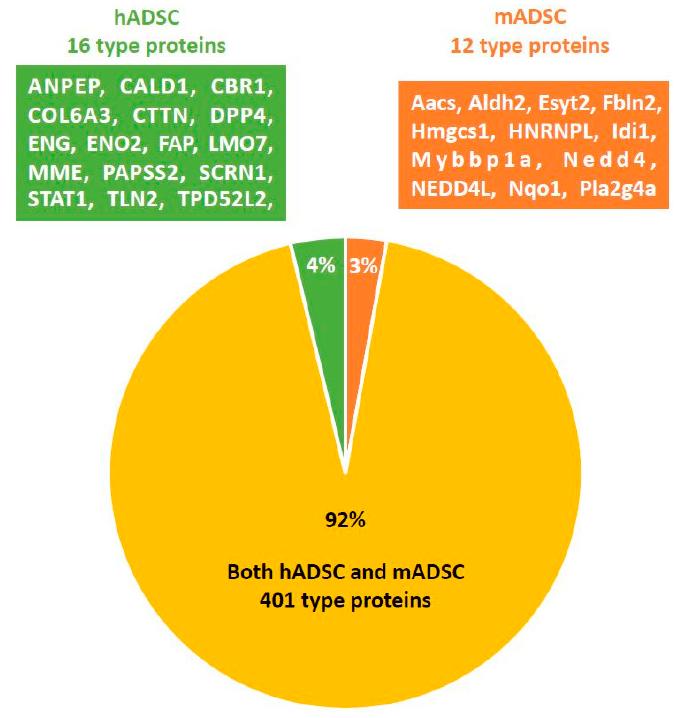
Figure 2. A Venn diagram of proteins detected by LC-MS/MS. A total of 417 proteins were identified from cultured hADSCs (Passage(P)3) and 413 proteins were identified from cultured mADSCs (P3). Among the 417 proteins identified in hADSCs, 16 were unique to hADSCs (hADSC group). Among the 413 proteins identified in mADSCs, 12 were unique to mADSCs (mADSC group). A total of 401 proteins were identified in both hADSCs and mADSCs (both hADSC and mADSC group).